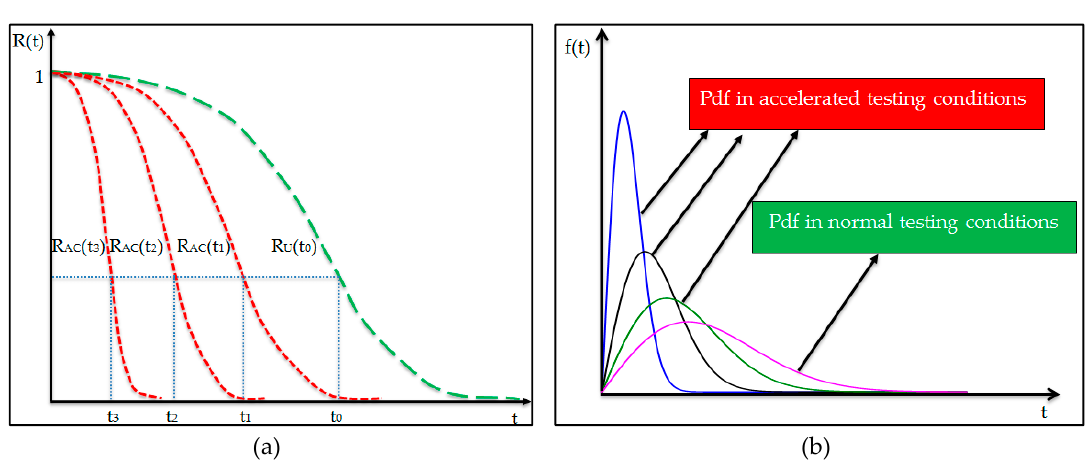
Figure 5. Equivalence of accelerated tests: ( a ) Variation of reliability under accelerated test conditions and in normal testing conditions; ( b ) variation of probability density in accelerated testing conditions and in normal testing conditions.